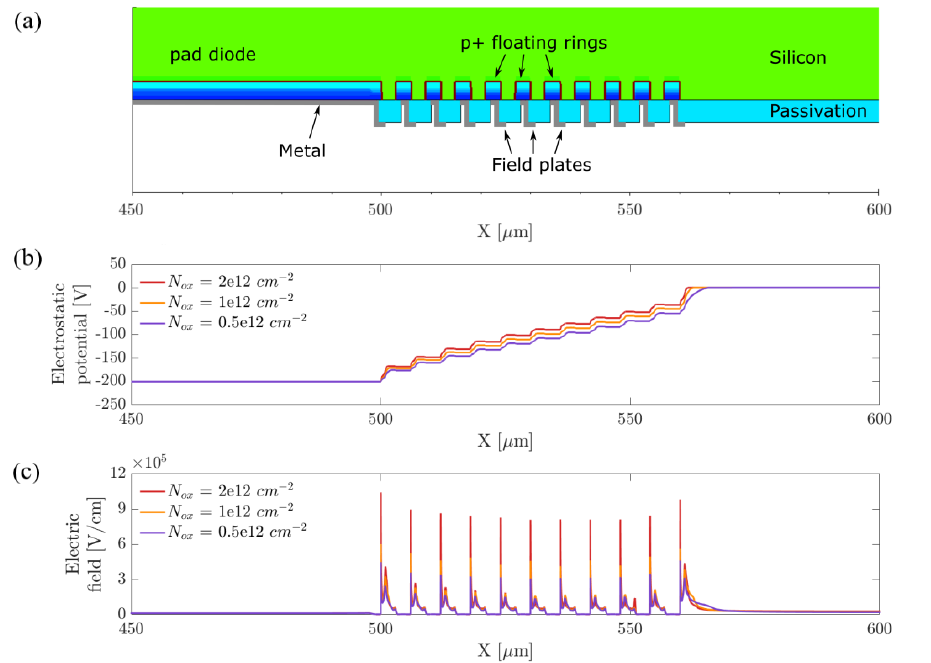
Figure 2. ( a ) Cross section of a guard ring structure in a simplified simulation domain. The green and the blue regions represent the low doped n-type silicon substrate and the p + implants of the backside guard rings and pad diode. The passivation layer is shown in light blue and the gray lines represent the metal field plates. ( b ) Electrostatic potential near the backside surface for three oxide charge concentrations. ( c ) Electric field near the backside surface for three oxide charge